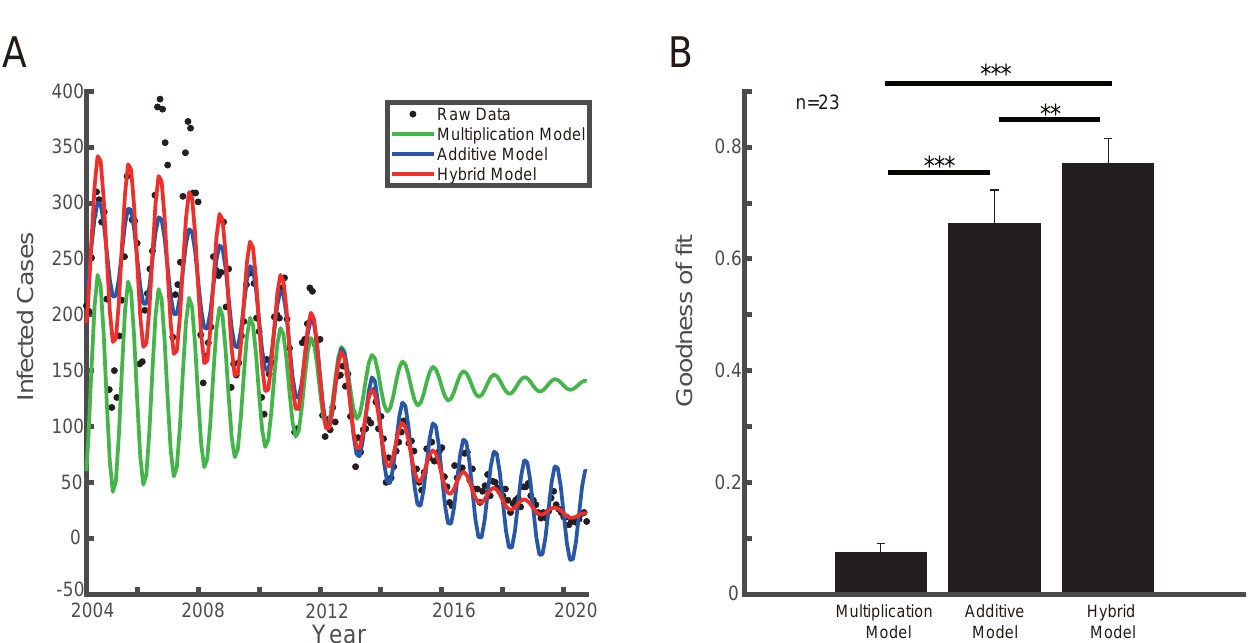
Fig 5. Model fitting and evaluation of three models. Plot A shows a fitting demonstration. Black dots represent the real observed data, and the solid lines in different colors are the models´ fitting curves (green for multiplication model, blue for additive model and red for hybrid model). Graph B shows the comparison of the fitting goodness of the three models ( �� represents for p < 0.01, ��� represents for p < 0.001).